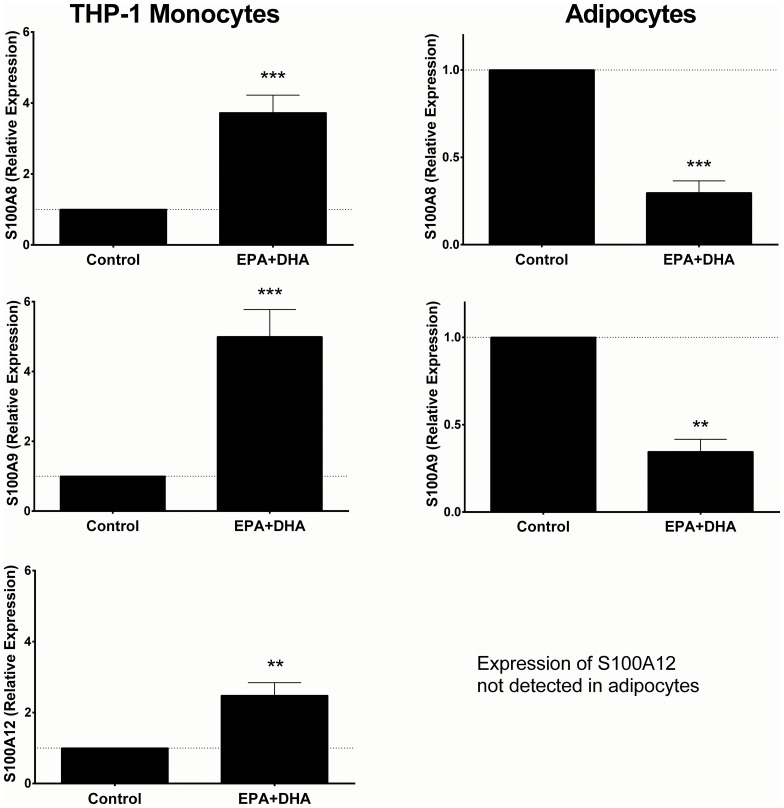
Expression of calgranulin genes (S100A8, S100A9, S100A12) is modulated by n-3 PUFA treatment in human THP-1 cells and adipocytes.*** indicates p<0.001; ** indicates p<0.01. Data plotted as mean fold change and standard deviation.